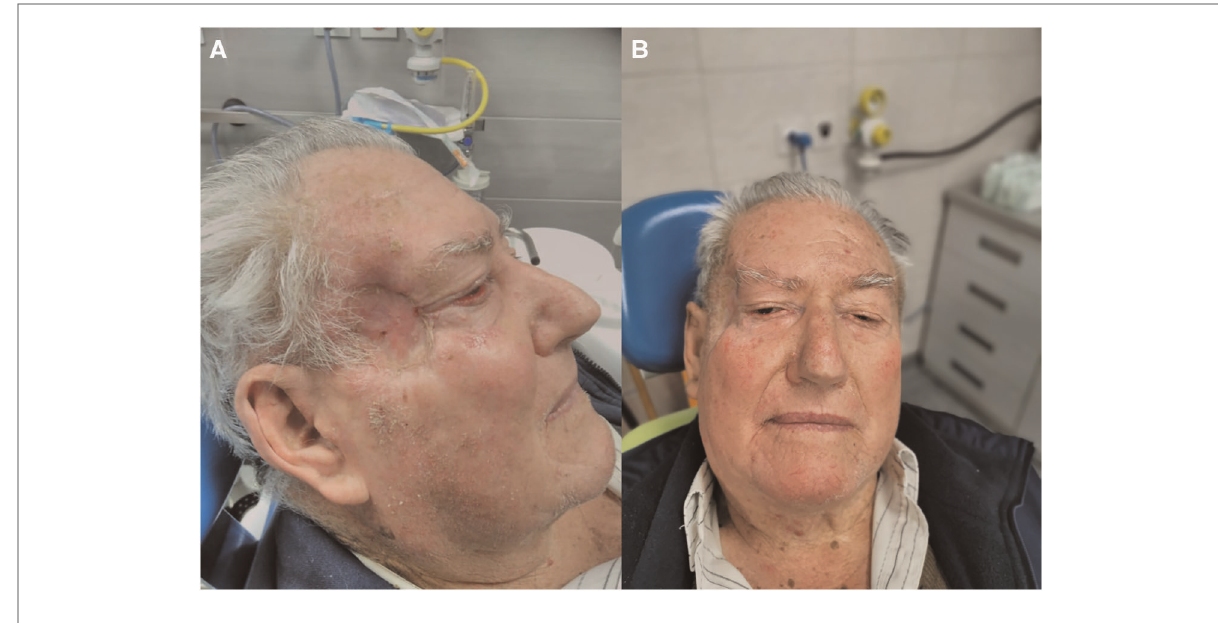
FIGURE 4 ( A,B ) Eyelids and mild face asymmetry after the